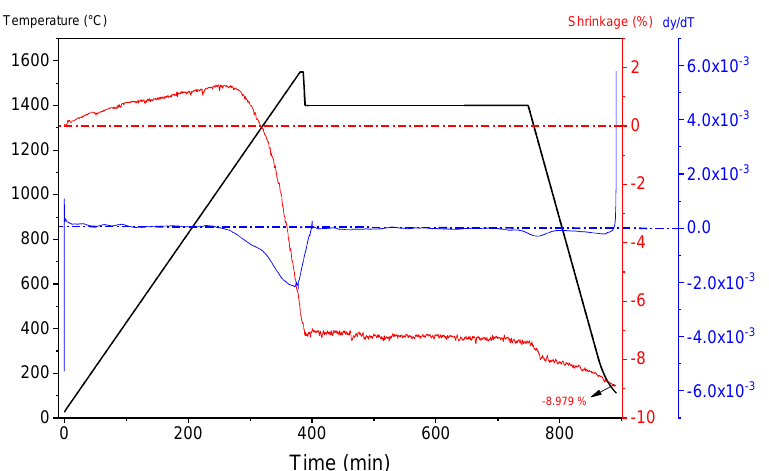
Figure 2. Dilatometry analysis of alumina containing 20 dwb. % of WAP sintered at optimal TSS conditions.